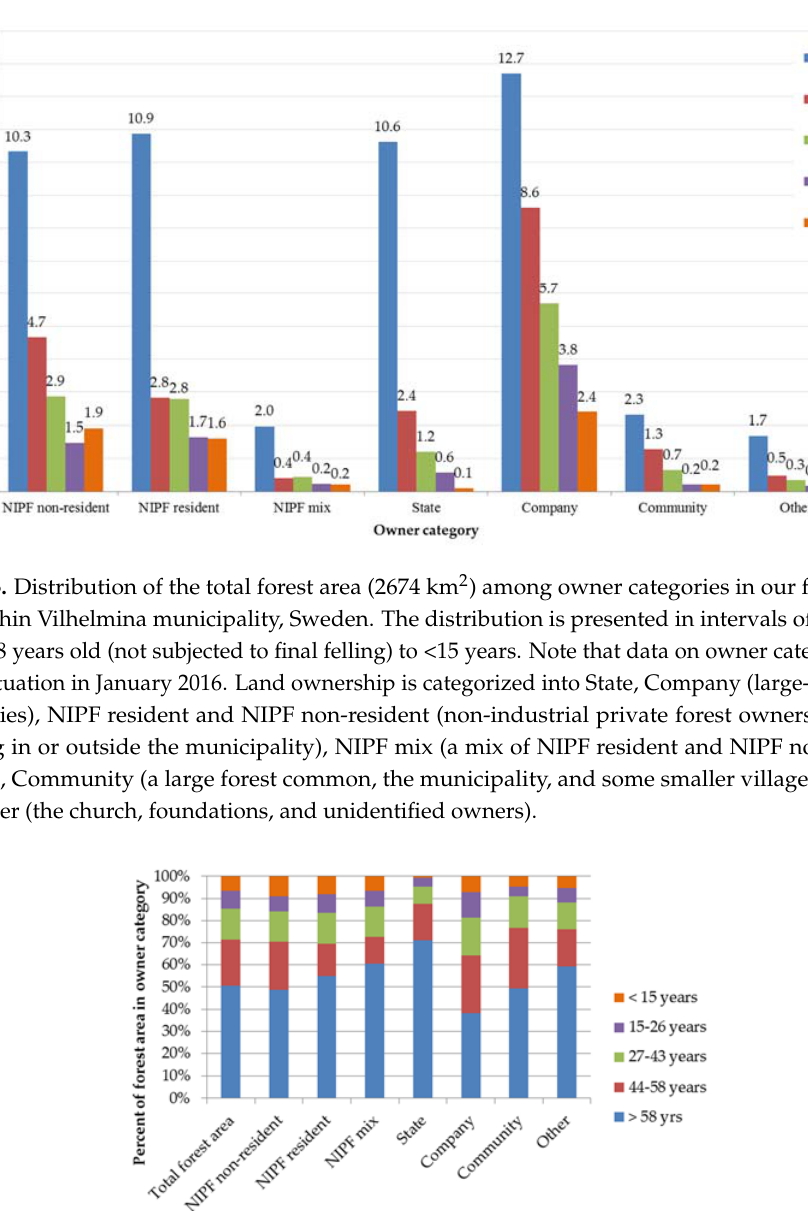
Figure 6. The distribution of forest age within forest owner categories in our focus study area within Vilhelmina municipality, Sweden. Note that data on owner category refers to the situation in January 2016. Land ownership is categorized into State, Company (large ‐ scale forest companies), NIPF resident and NIPF non ‐ resident (non ‐ industrial private forest owners identified as living in or outside the municipality), NIPF mix (a mix of NIPF resident and NIPF non ‐ resident owners), Community (a large forest common, the municipality, and some smaller village commons) and Other (the church, foundations, and unidentified owners).